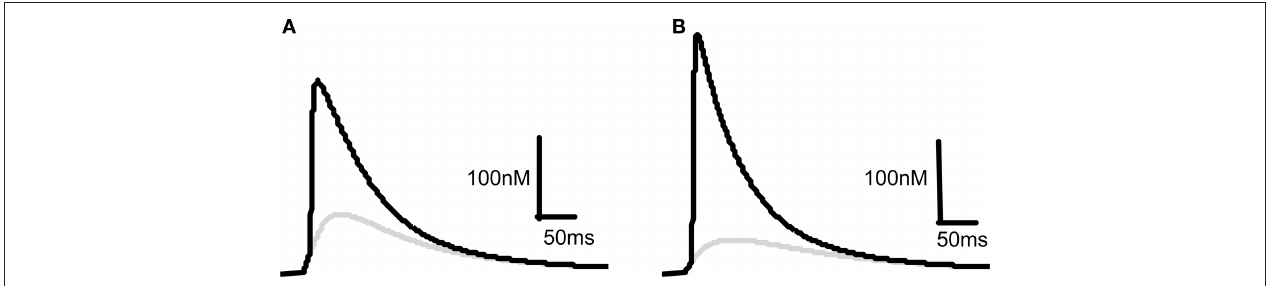
Figure 2 | Comparison of predicted [Ca 2 + ] dynamics in dendritic spines and in the soma. [Ca 2 + ] profiles in response to a 10 mV EPSP at the spine (A) or a 1 mV EPSP at the soma (B) on their own (gray) or in combination with a BPAP (black) of amplitude 60 mV at the spine (A) or 100 mV at the soma (B) . The delay between EPSP and BPAP initiation is 10